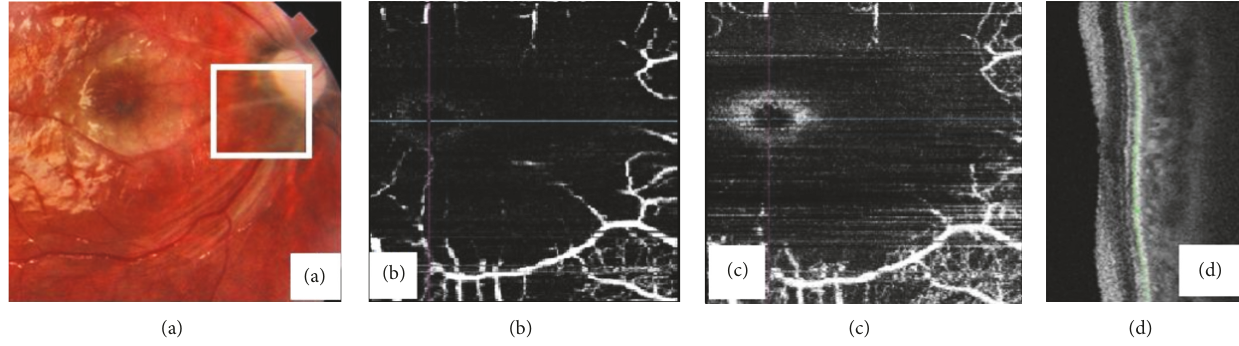
Figure 2: (a) “Ghost-” like cilioretinal vessel(Boxed) impression secondary to occlusion. Note the loss of the perifoveolar capillary plexuses in both superficial and deep plexus (b)and (c) with edema of the perimacular nerve fibre